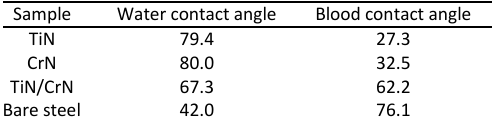
Fig. 8. Diagram of contact angle values for the examined samples Table 3. Contact angle values for the